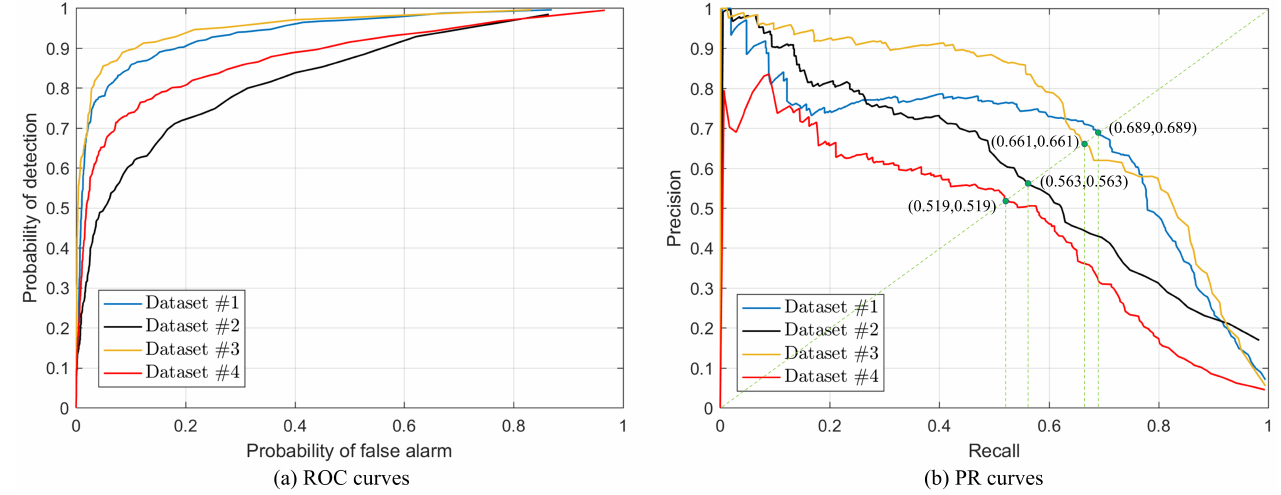
Figure 3. ROC ( a ) and PR ( b ) curves of AWSG generated